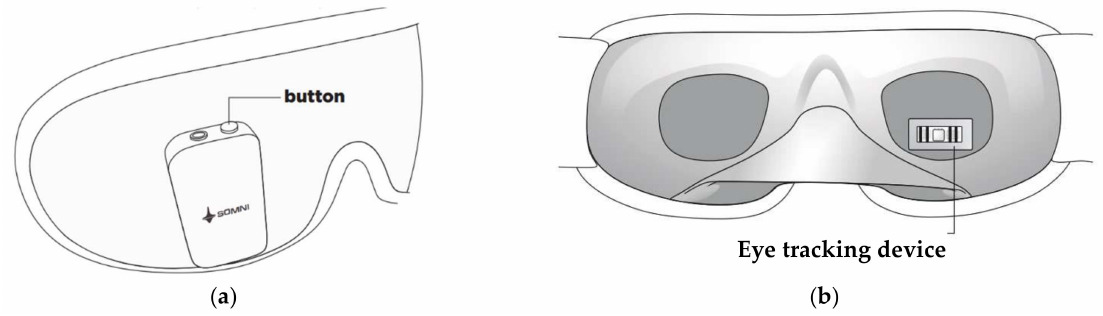
Figure 5. External ( a ) and internal ( b ) views of the Somni mask